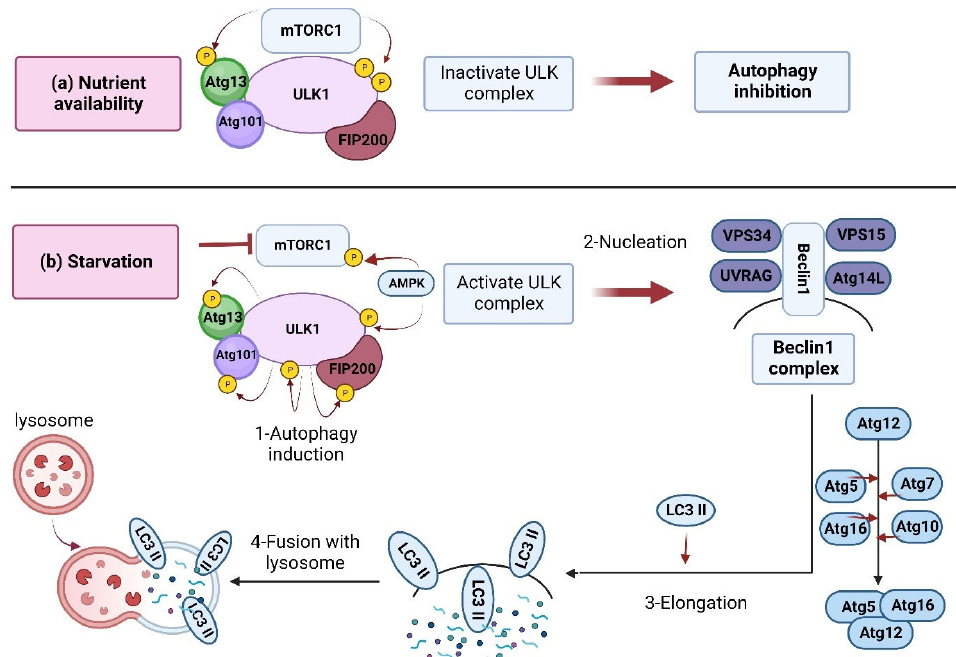
Figure 2. Inhibition and induction of autophagy. ( a ) Nutrient availability: when nutrients are available, mTORC1 is activated and forms a complex accompanied by ULK1, Atg13, Atg101, and FIP200 (200 kDa FAK-family interacting protein) [23]. The developed complex inactivates ULK1 through its phosphorylation, which inhibits autophagy. ( b ) In starvation conditions, mTORC1 is inhibited by dissociation from the ULK1 complex. Meanwhile, the ULK1 is dephosphorylated and activated by AMPK. The activated ULK1 induces autophagy by phosphorylation of Atg13 and FIP200. Then, the Beclin-1 (Bcl-2-interacting protein) is released from Bcl-2 to form a complex with a set of proteins, including Vps34, Vps15, and Atg14L, resulting in autophagosome formation/maturation [23]. This process is accomplished via the Atg proteins in two ubiquitin-like conjugation pathways [24]. Finally, the lipidated LC3 (LC3-II) is localized to the autophagolysosome membrane [25]. LC3 interacts with p62 to engulf ubiquitinated proteins, and within the autophagolysosomes, the lysosomal hydrolases will then degrade the